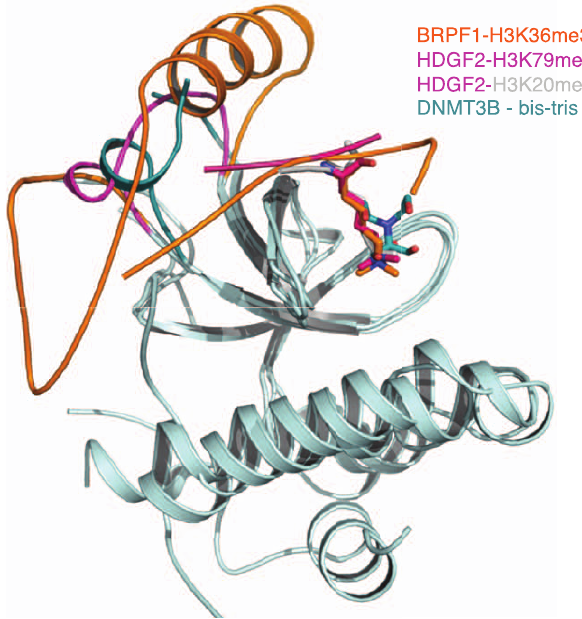
Figure 6. The peptides share a similar binding mode in the complex structures of BRPF1-H3K36me3, HDGF2-H3K79me3 and HDGF2-H4K20me3. The bis-tris molecules in the DNMT3A/ DNMT3B complex structures are bound at the same site as the tri- methyl-ammonium group of the methyllysine (DNMT3A structure is not shown here for clarity). The insertion motifs from these three PWWP domains may play a role in conferring the ligand specificity.